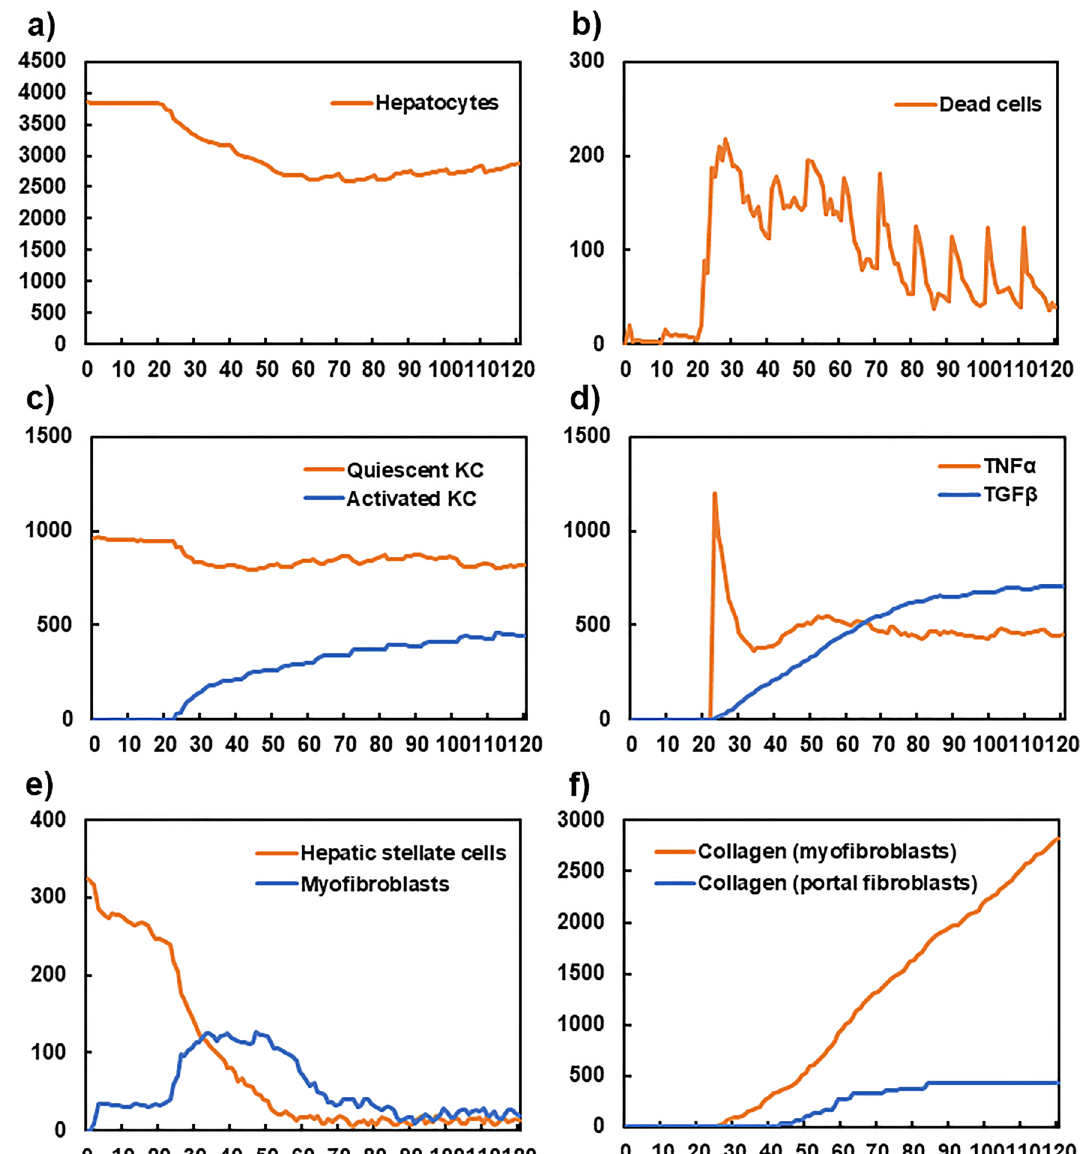
cells ( c ), TNF-α and TGF-β ( d ), HSCs and myofibroblasts ( e ), and myofibroblast- and portal fibroblast-derived collagens ( f